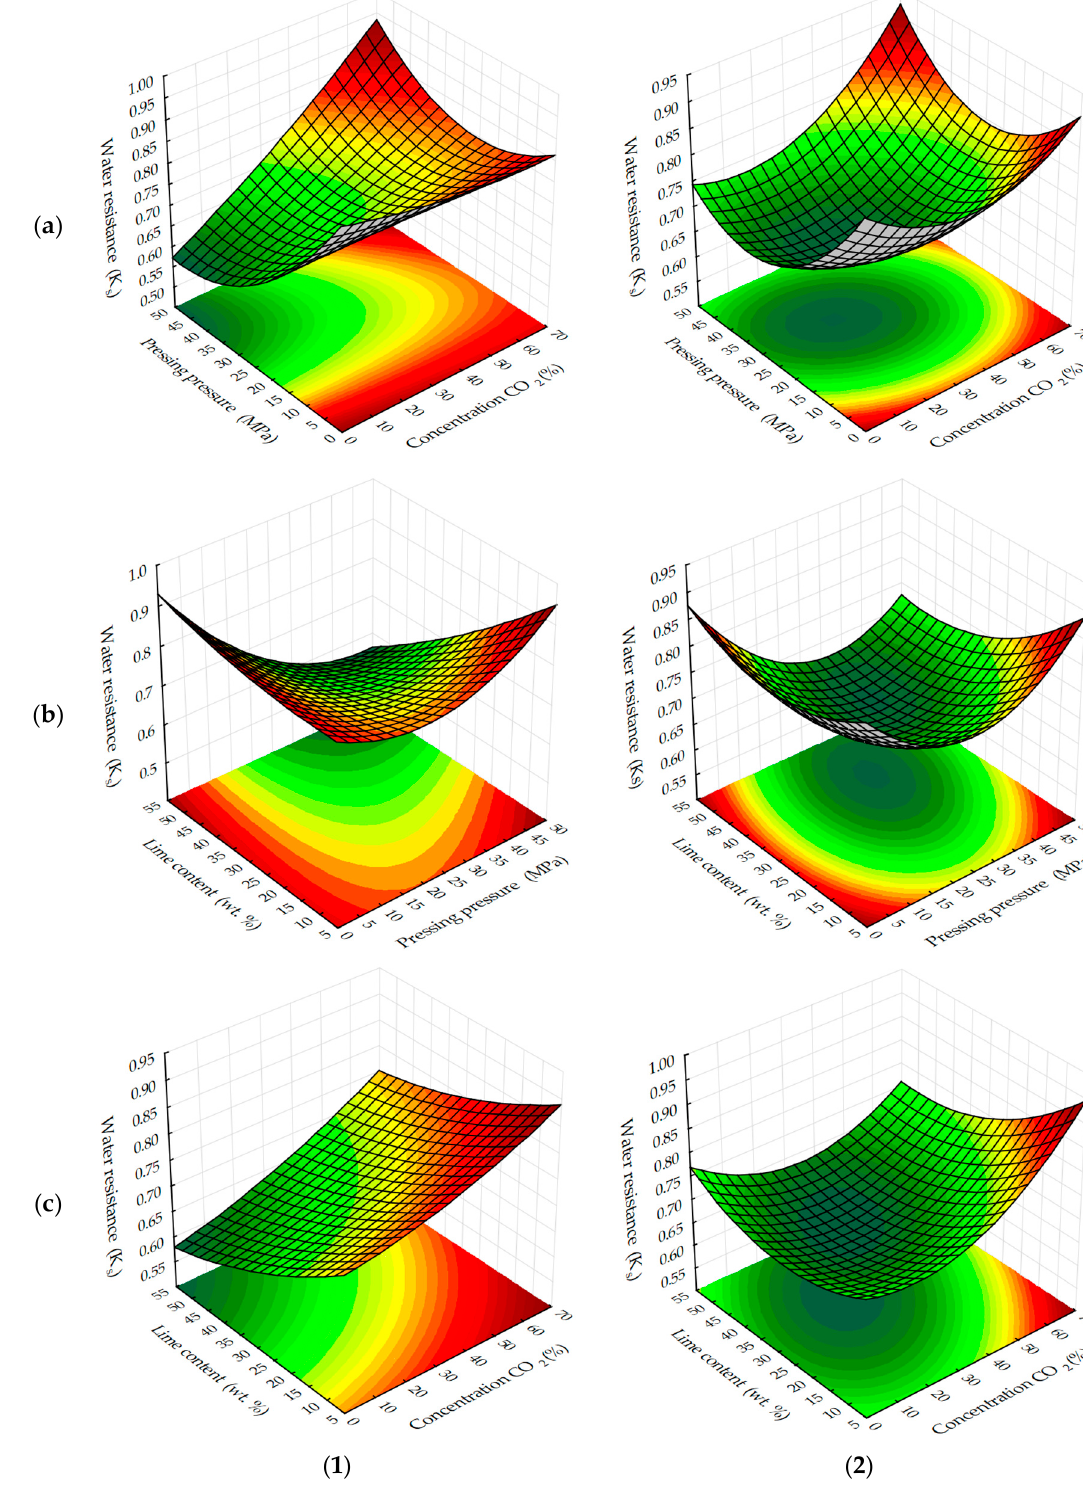
Figure 7. Response surfaces to changes in the water-resistance of testing samples carbonated by dynamic ( 1 ) and static ( 2 ) methods, depending on: ( a ) pressing pressure and CO 2 concentration; ( b ) the lime dust content and pressing pressure; ( c ) the lime dust content and CO 2 concentration (at zero level of variation of other factors).